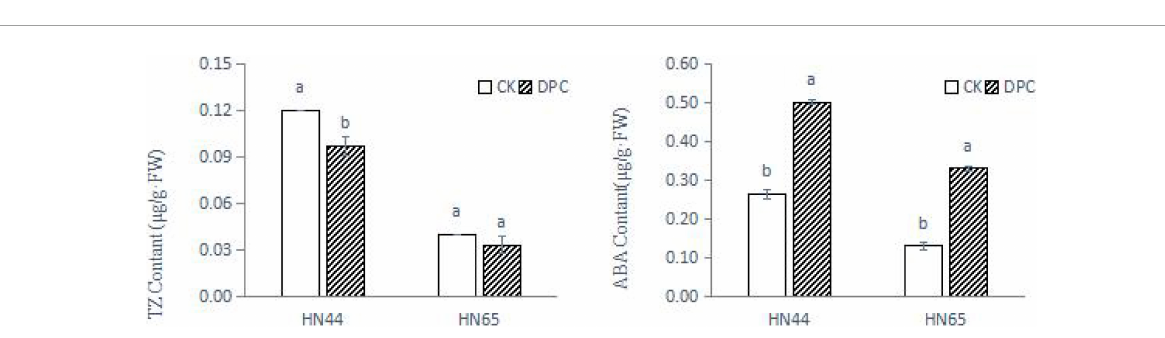
pathways of flavonoids and isoflavones were also involved, proving that DPC had an effect on plant